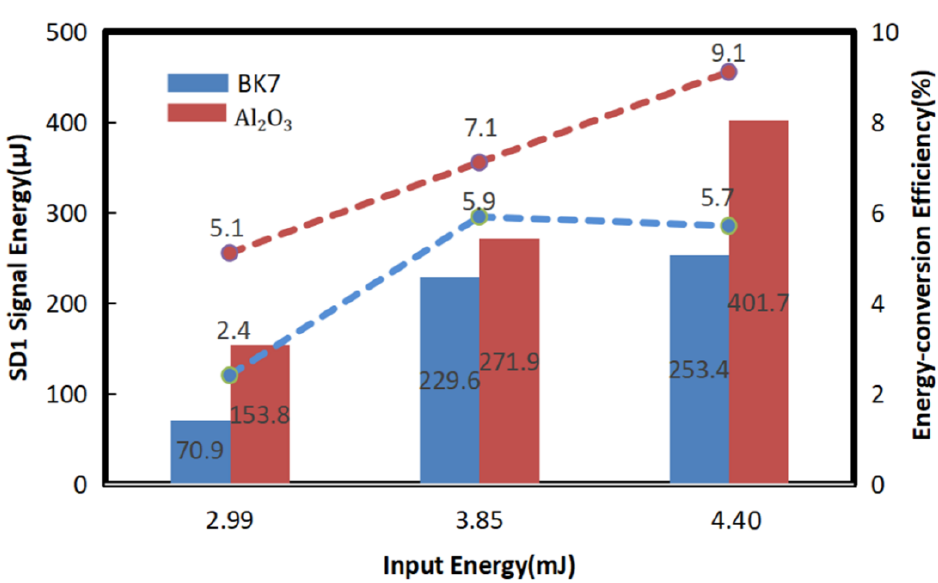
Figure 6. SD + 1 signal energies and energy-conversion efficiencies when using BK7 glasses and AL 2 O 3 in the SD process with different input energies.